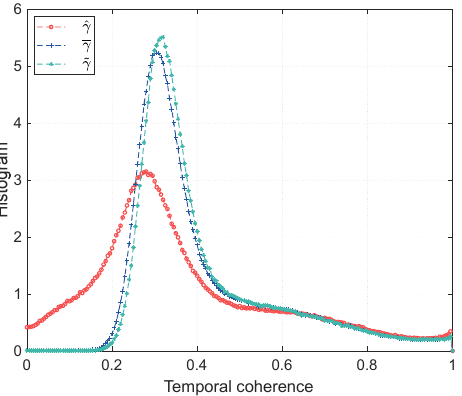
Figure 13. Histogram of temporal coherence for phase estimation using different coherence magni- tude estimators.